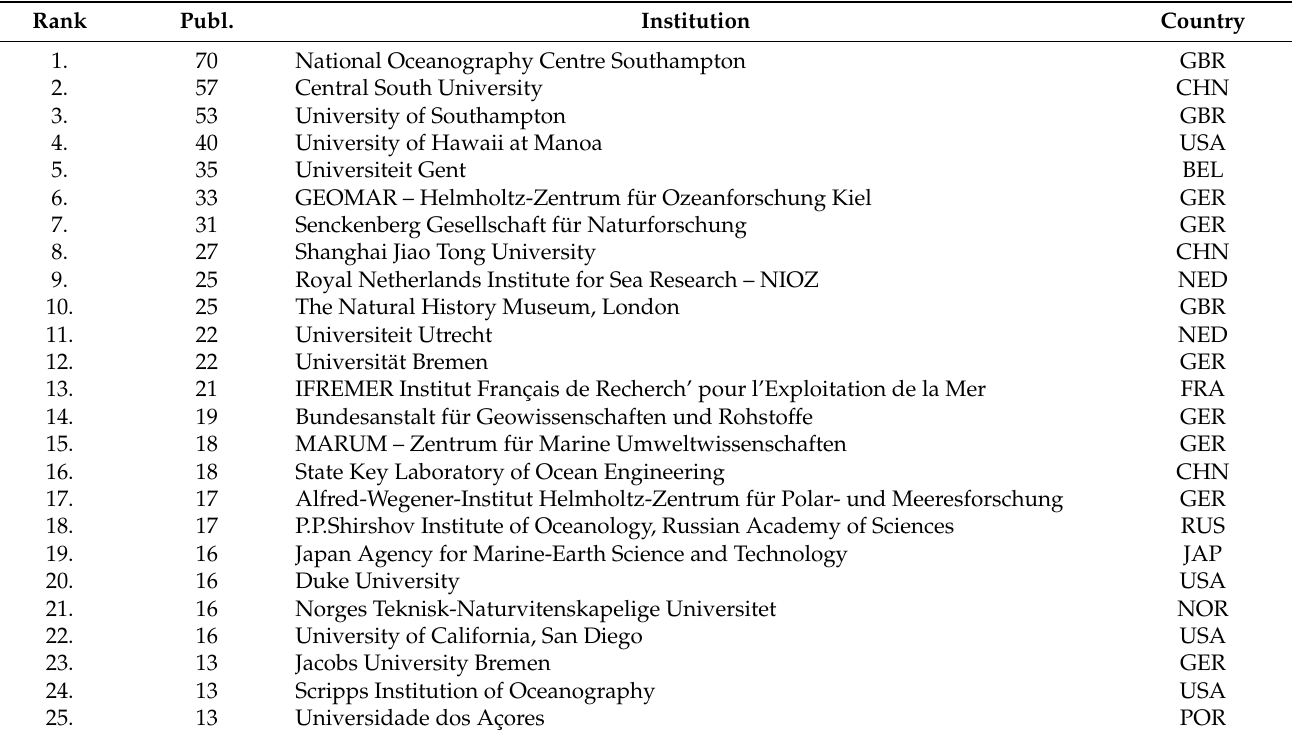
Table 5. Top 25 institutions with respect to publication numbers